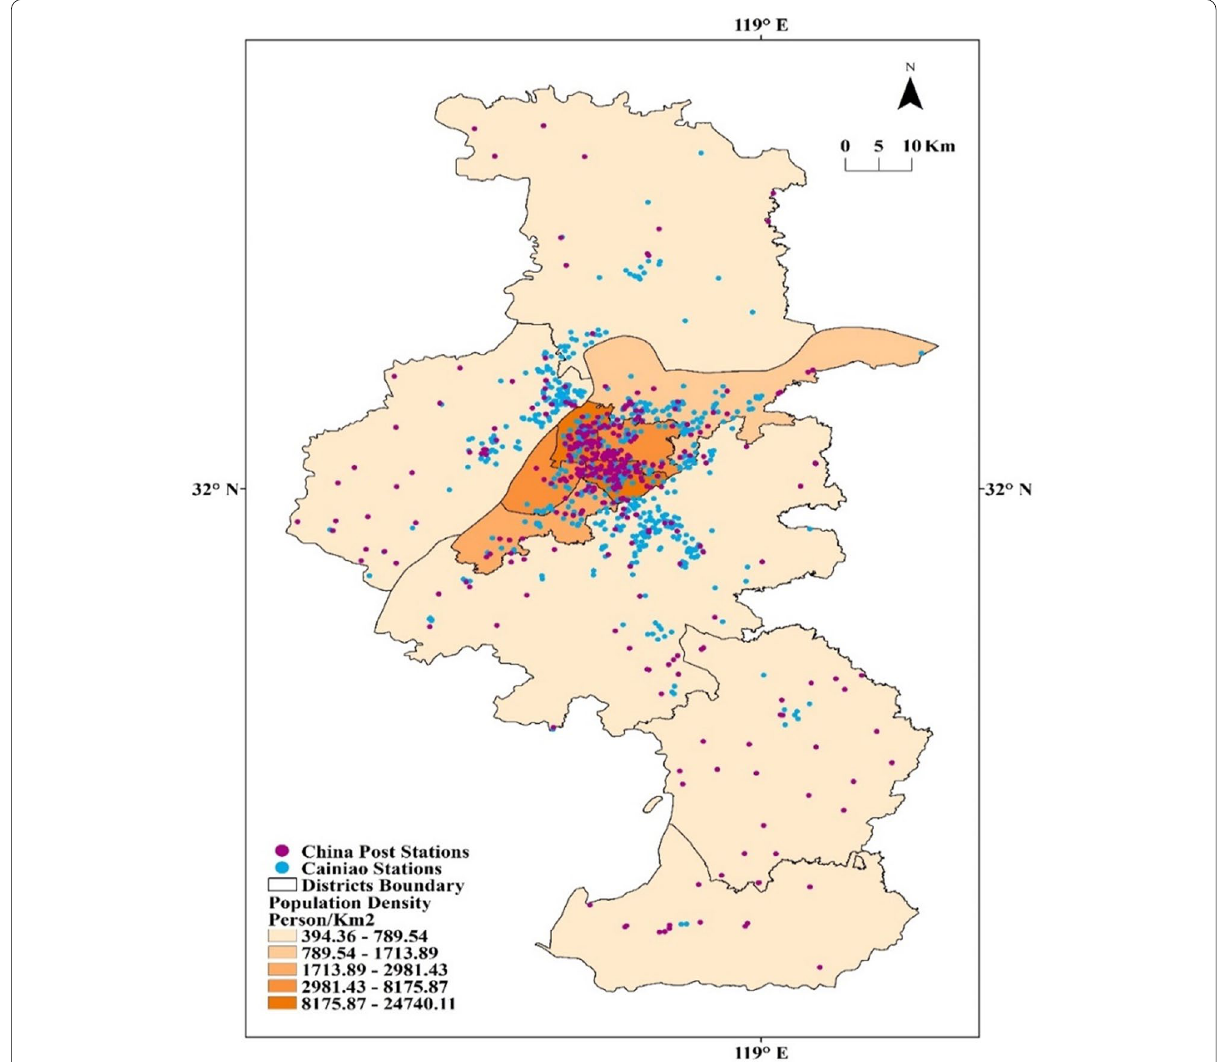
Fig. 2 The geographical distribution of CDPs and population density in